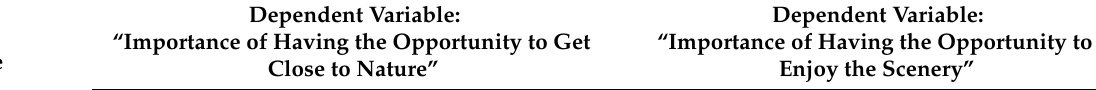
Table 4. Regression results for the motives related to the natural environment element.